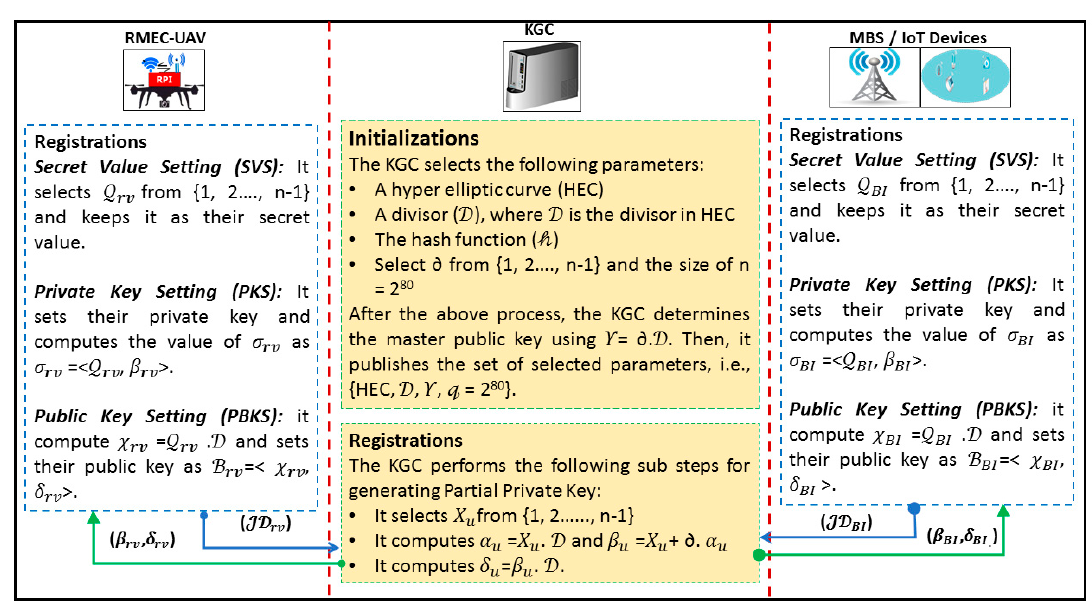
Table 1. Notations used in proposed